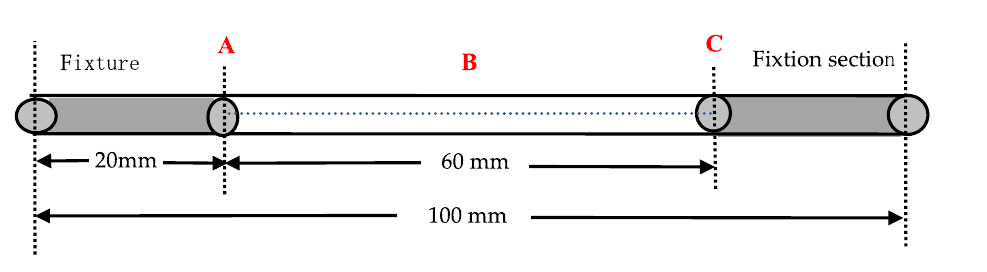
Figure 1. The schematic diagram of test